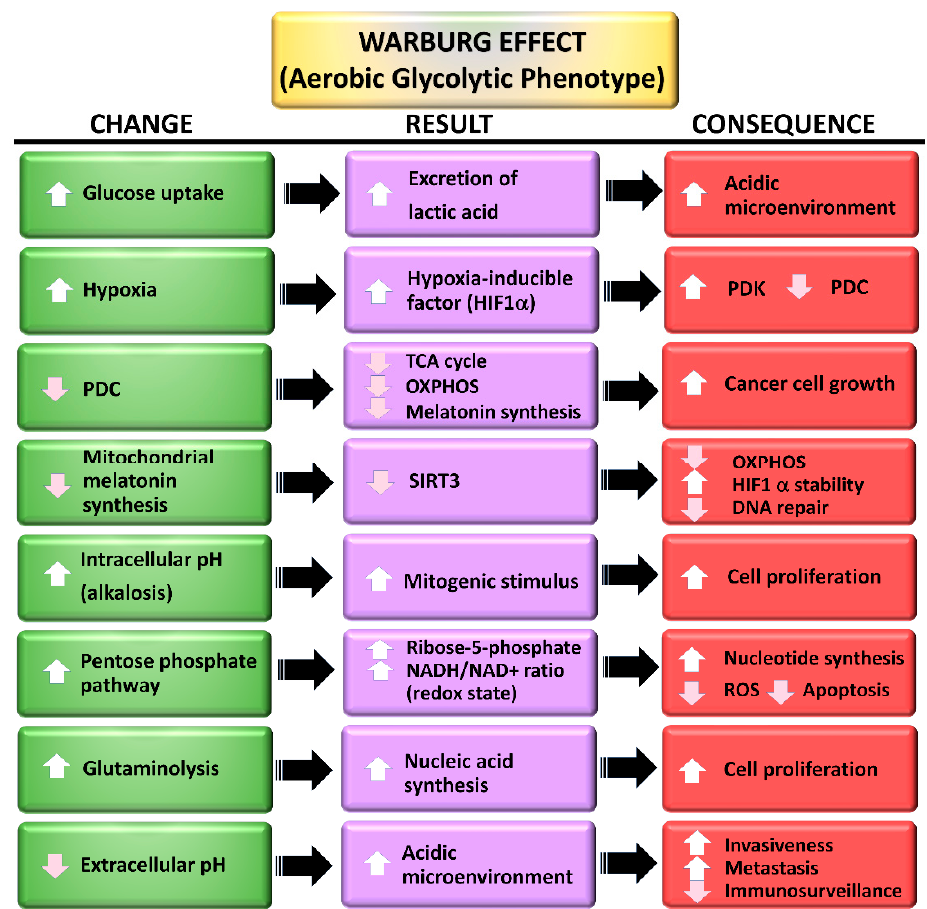
Figure 3. The Warburg effect which has been most thoroughly studied in solid tumor cells, is not unique to cancers as indicated in the current review. The major changes include and upregulated glucose metabolism pathway which is associated with a large number of other alterations as summarized in this figure. Another major alteration that occurs is that the cells reduce the activity of the tricarboxylic cycle (TAC) and oxidation phosphorylation (OXPHOS) for ATP production by precluding the synthesis of acetyl CoA due to the down regulation of the associated enzyme pyruvate dehydrogenase complex (PDC). This shunts pyruvate into the cytosolic fermentation pathway which results in the production of lactate. The pentose phosphate pathway (see Figure 4) is also activated leading to the synthesis of a variety of molecules that ensure nucleotide synthesis and underpin cellular proliferation. HIF-1 α = hypoxia inducible factor-1 α ; PDK = pyruvate dehydrogenase kinase; SIRT3 = sirtuin 3.